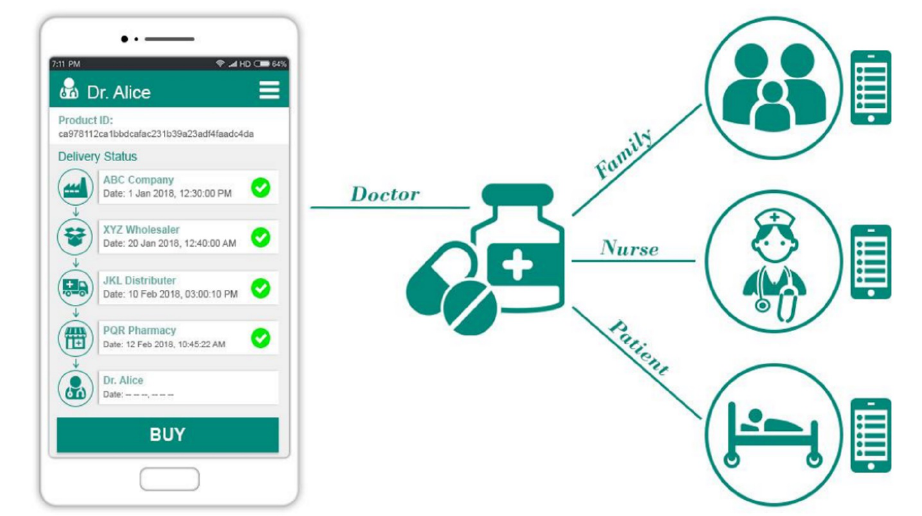
Figure 1: Proposed BT Software Application frontend layout (Haq & Esuka, 2018)